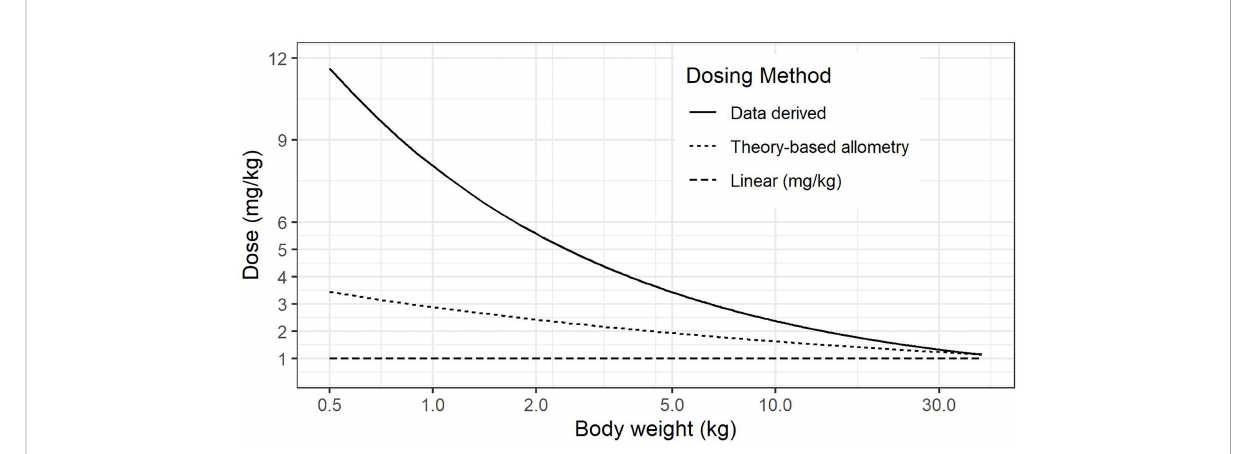
FIGURE 1 Comparison of calculated dose (mg/kg) for linear, theory-based allometry and data-driven methods